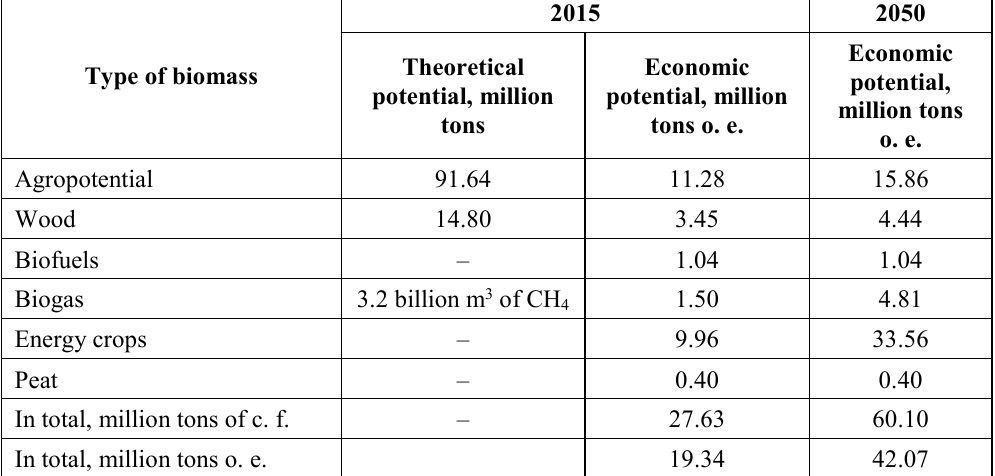
Table 2. Bioenergy Potential of